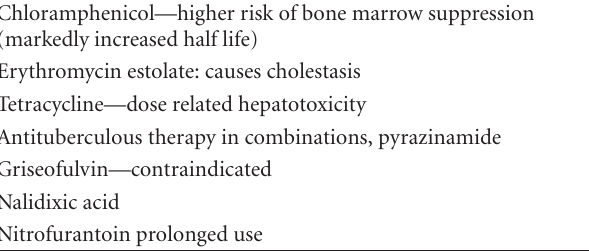
Table 1: Antibiotics to be avoided in liver